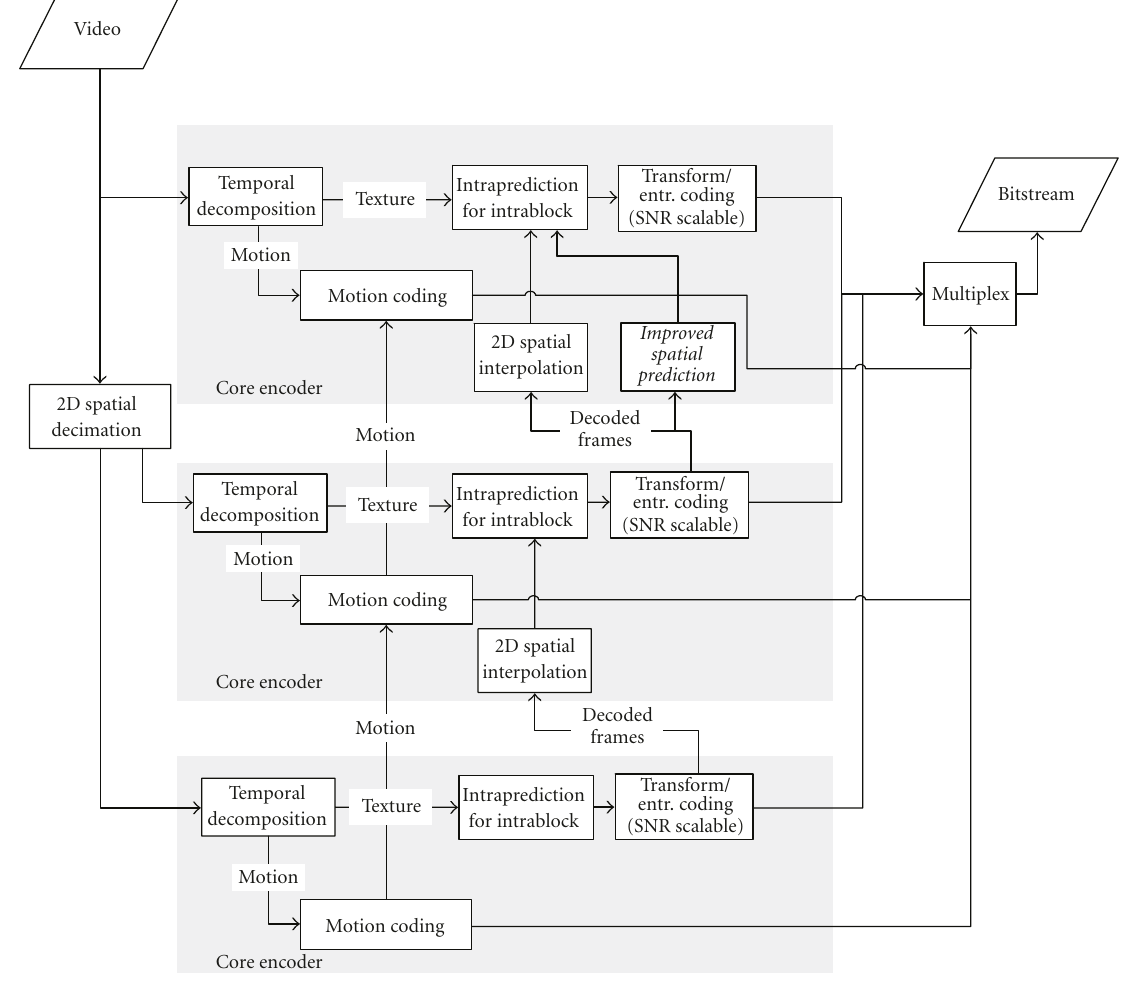
Figure 6: Improved scalable encoder using a multiscale pyramid with 3 levels of spatial scalability [1]. The proposed algorithm is embedded in the “improved spatial prediction” module for the spatial intraprediction of the SD layer from the CIF layer for I and P